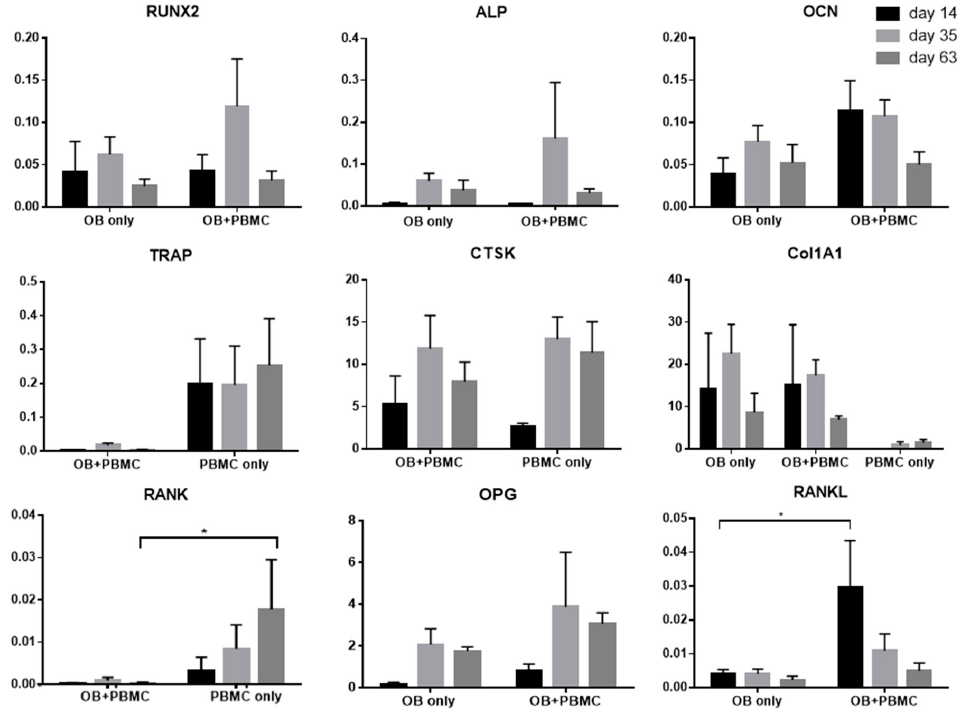
Figure 5. Gene expression ( ∆ CT method) relative to β -tubulin (house-keeping gene). Mean ± SEM, N = 4. * p < 0.05.